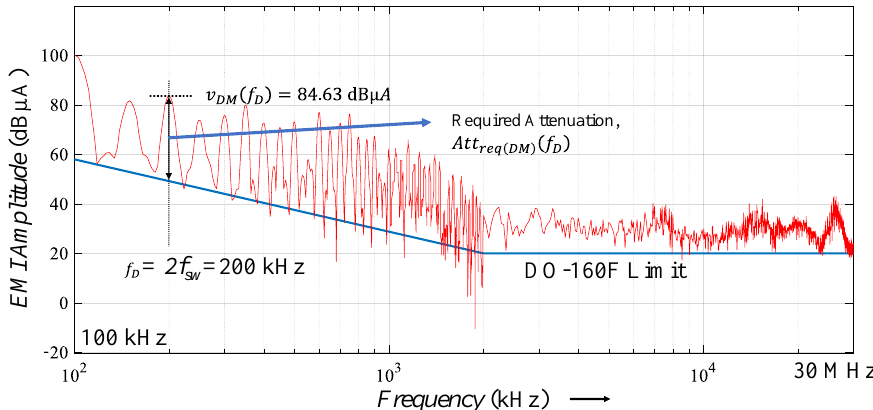
Figure 3. Unfiltered EMI spectrum of the three-phase boost PFC under study.